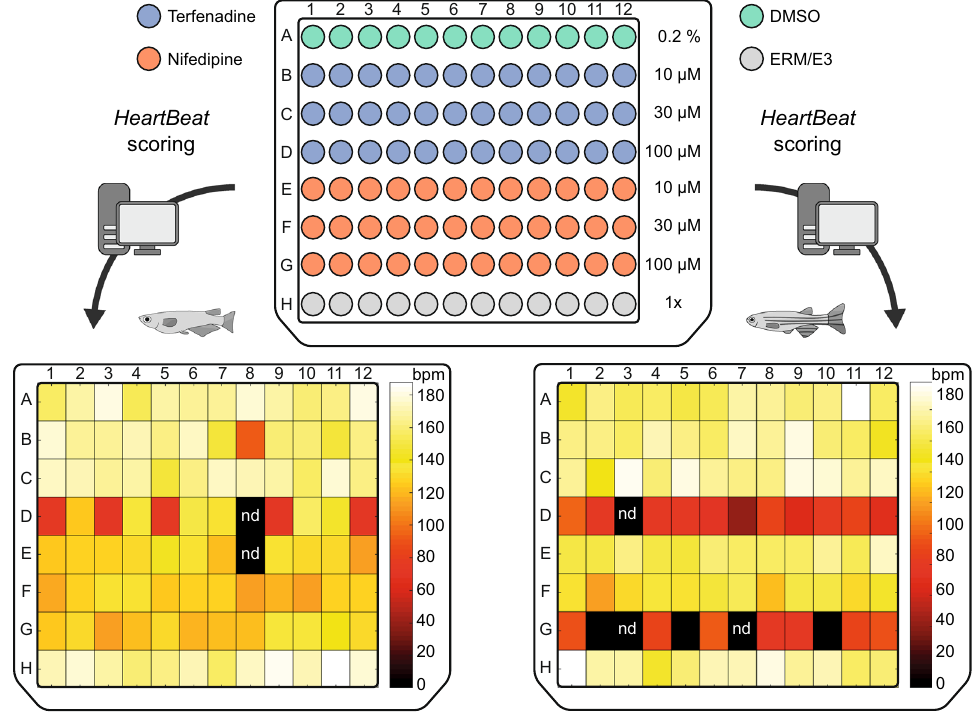
Figure 6. Quantification of heart rates in fish embryos treated with compounds. 96-well format for incubation of medaka and zebrafish embryos with terfenadine and nifedipine each at three different concentrations in µ M. As a control for stage-dependent changes of heart rate, all measurements (drugs and DMSO) were normalized to a negative control group of age-matched untreated embryos (row H). The HeartBeat software directly provides a heatmap output for intuitive assessment of drug effects (heart rate response shown at 90 min; nd: not